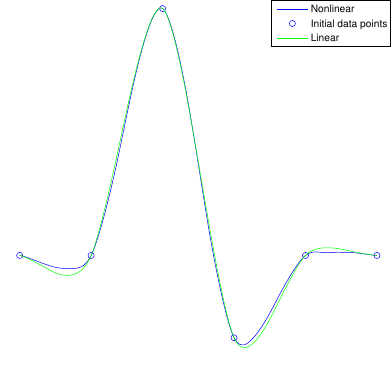
Figure 1. Initial control points and curve generated by 5-point linear ternary interpolating subdivison scheme (5th level) in (9) and 5-point nonlinear ternary interpolating subdivision scheme (11) with w = 1/230.